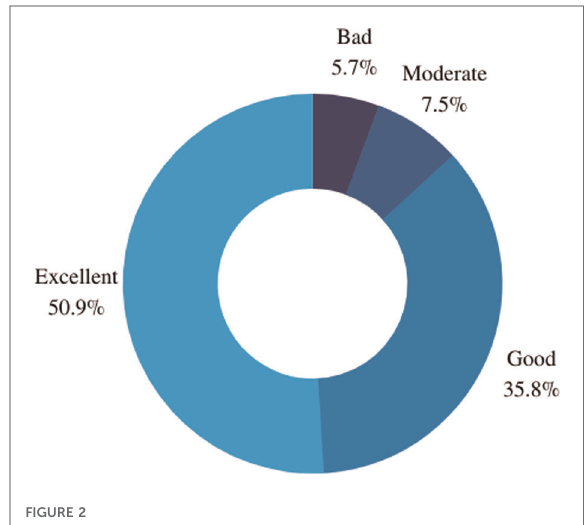
FIGURE 2 Self-declared health state in the last seven days.